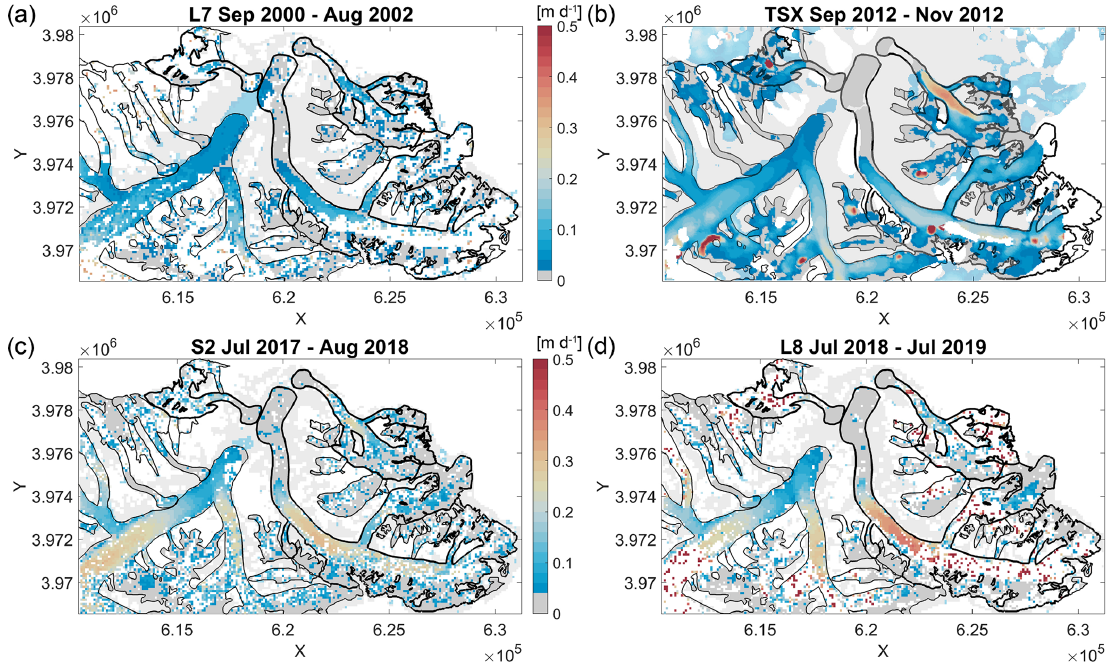
Figure 5. Temporal evolution of 2D surface flow velocities for the three glaciers before 2020 derived from (a) Landsat 7, (b) TerraSAR-X, (c) Sentinel-2 and (d) Landsat 8. The dates of the compared images are given at the top of each panel. Grey values refer to velocities smaller than the uncertainty (see Table S2), i.e. < 0.01md − 1 for panels (a) and (b) and < 0.02md − 1 for (c) and (d)